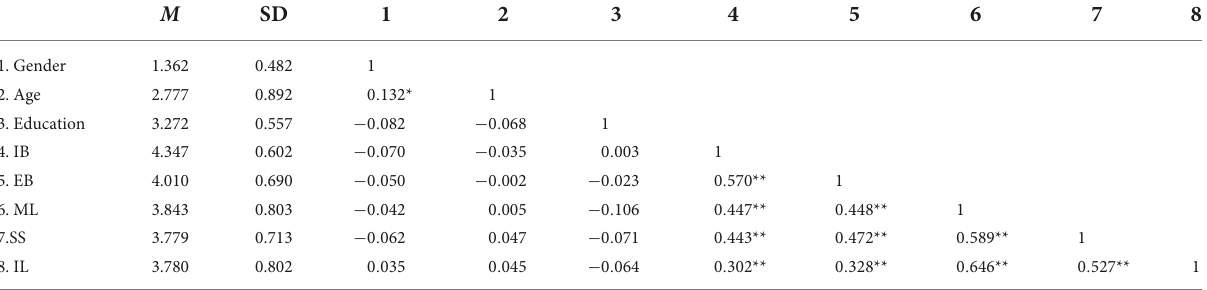
TABLE 2 Means, standard deviations, and correlation coefficient analysis of the variables.